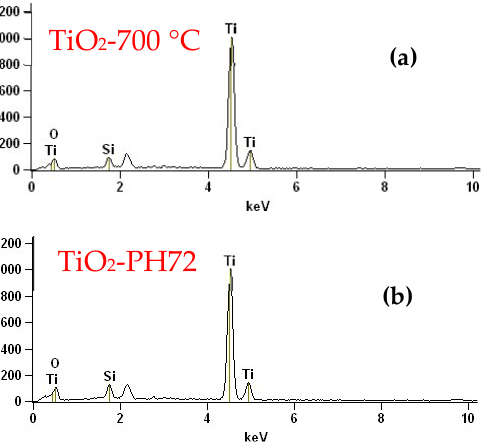
Figure 6. XPS spectra of the TiO 2 fiber obtained after calcination at different temperatures and plasma treatments: ( a ) survey spectra, ( b ) Ti 2p spectra, and ( c ) O 1s spectra.